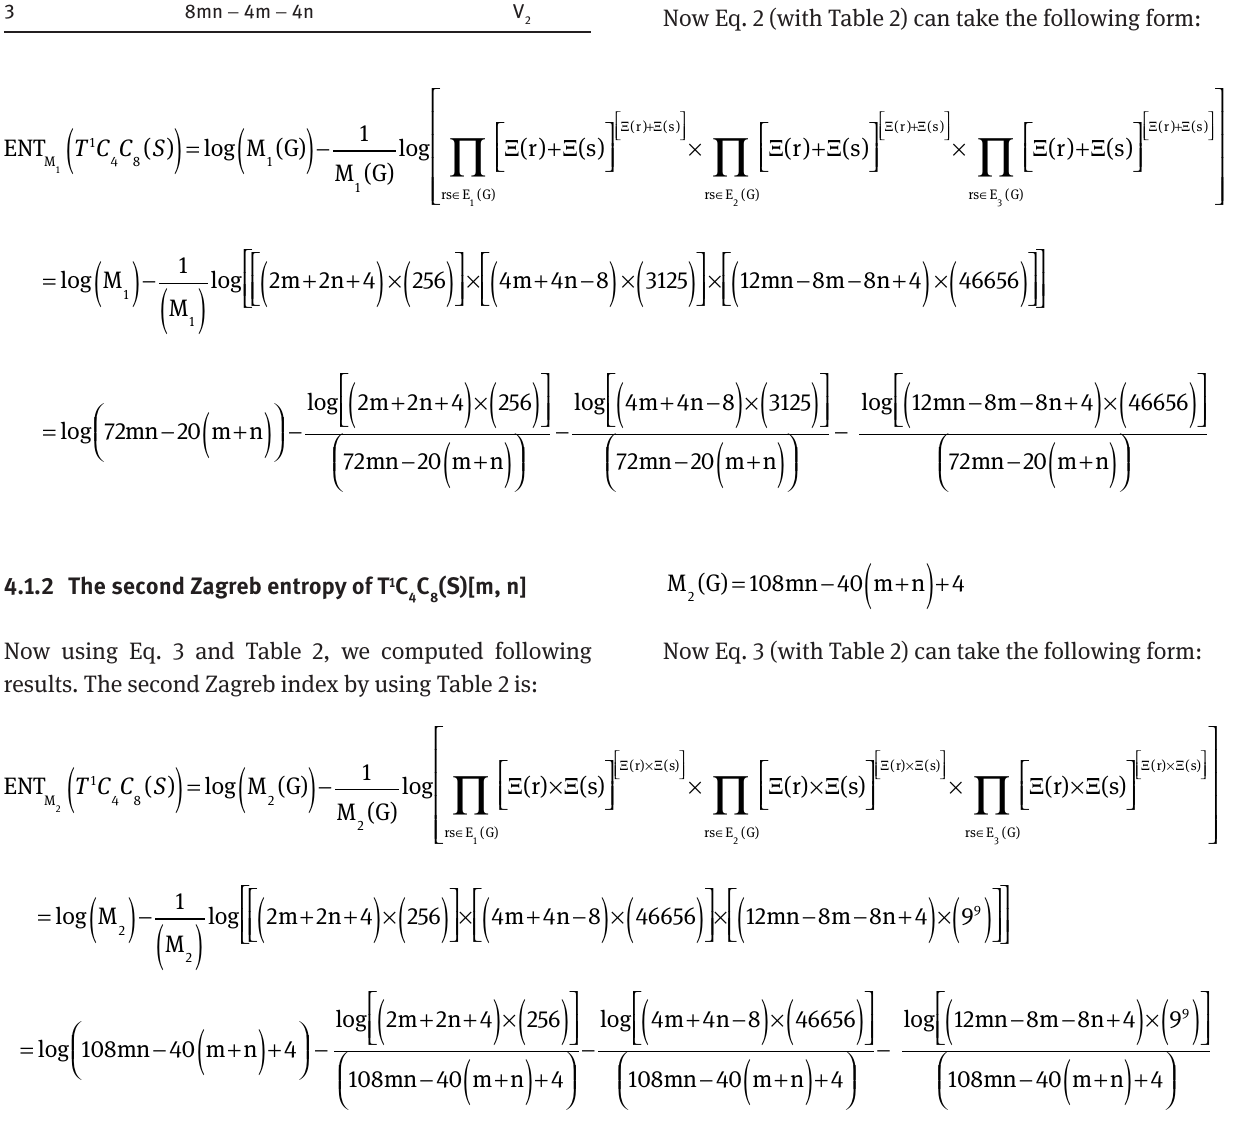
Table 1: Vertex partition of T 1 C